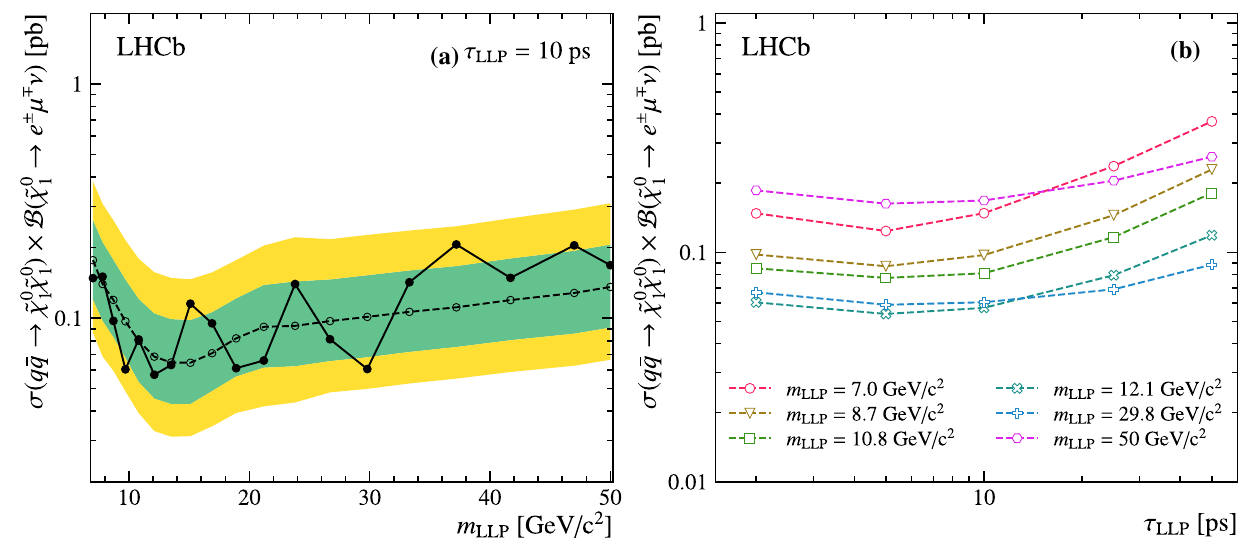
Fig. 6 a Expected (open circles and dotted line) and observed (filled circles and solid line) upper limits of the cross-section as a function of m LLP for τ LLP = 10ps, for LLPs produced through the DPP mecha- nism. The green and yellow bands indicate the quantiles of the expected